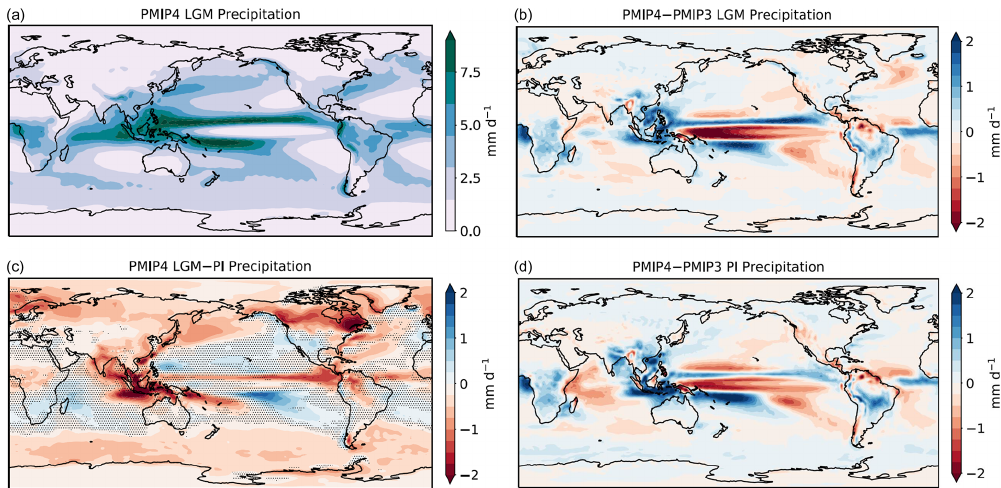
Figure 6. (a, b) PMIP4-CMIP6 multi-model LGM mean annual precipitation in mmd − 1 . (c) PMIP4-CMIP6 multi-model LGM–PI mean annual precipitation anomaly (mmd − 1 ) with stippling showing areas where less than nine models agree on the sign of change. (b) Difference between the PMIP4-CMIP6 and the PMIP3 multi-model means of the LGM mean annual precipitation (mmd − 1 ). (d) Difference between the PMIP4-CMIP6 and the PMIP3 multi-model means of the PI mean annual precipitation (mmd − 1